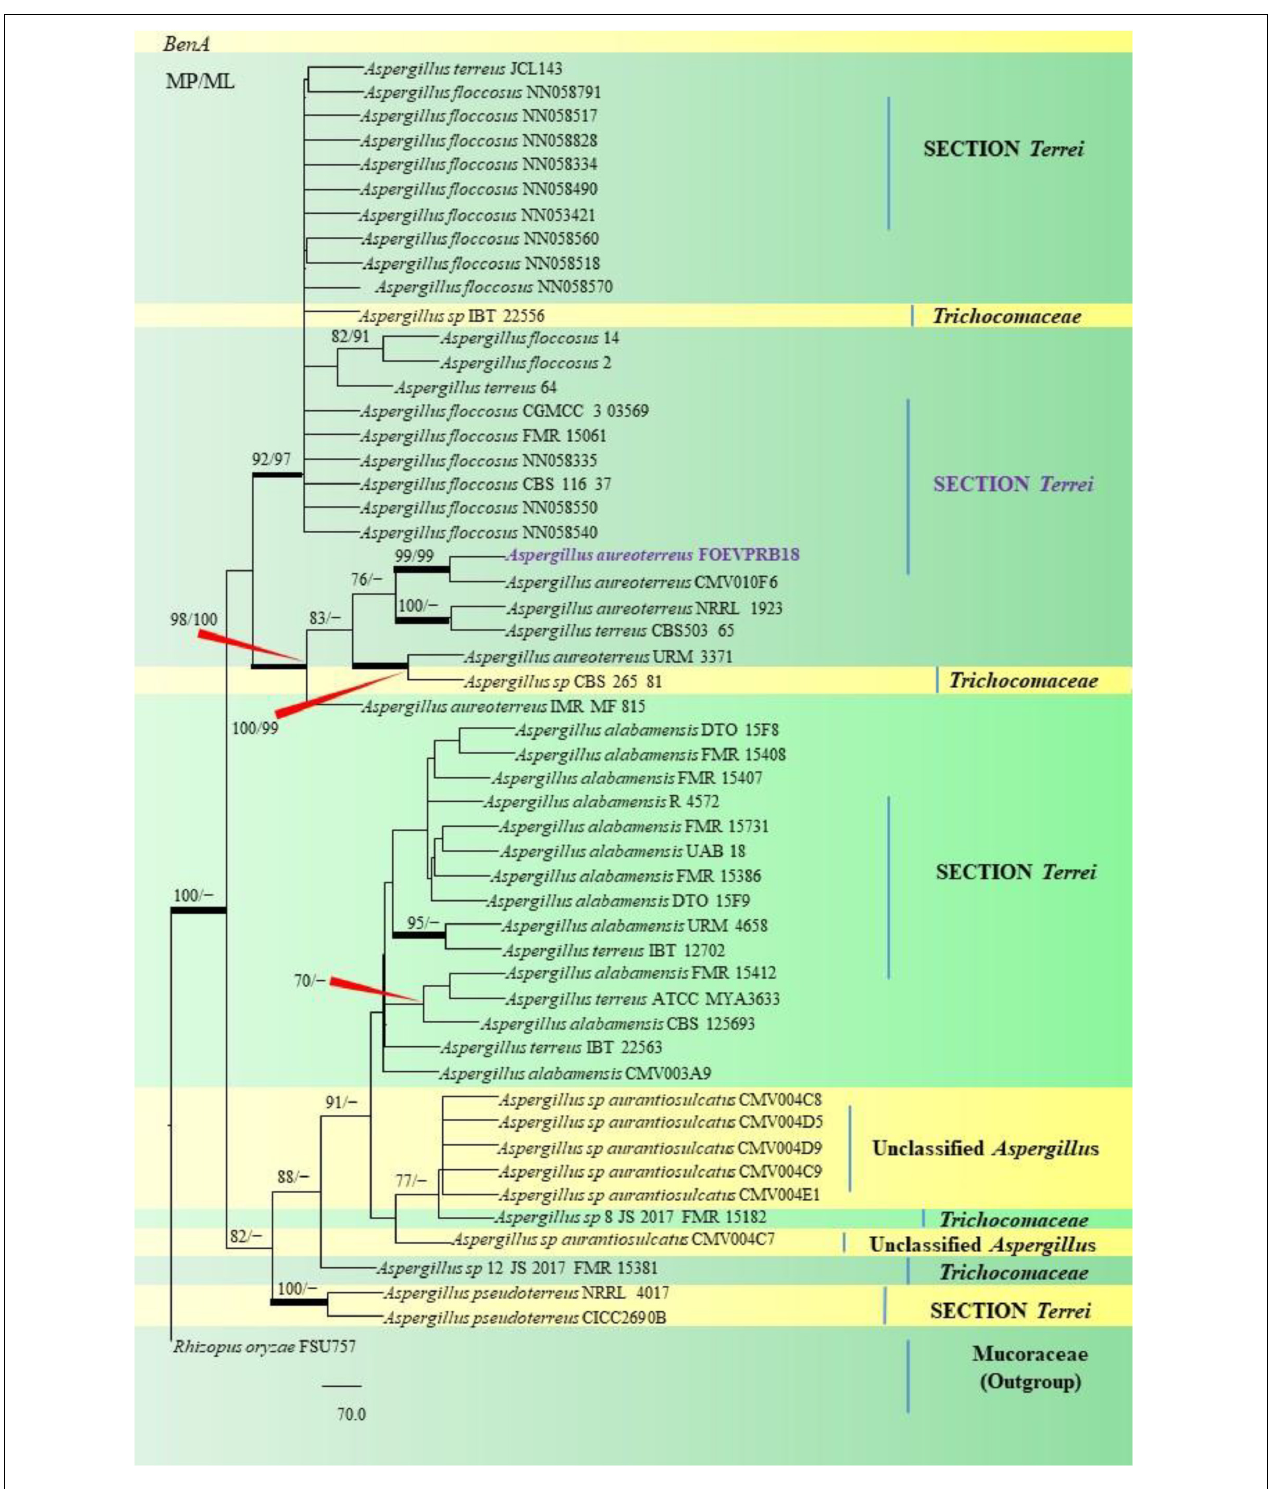
FIGURE 7 | A phylogenetic tree (taxon branching diagram) presents the genetic analysis of the Aspergillus aureoterreus FOEVPRB18 clade belonging to the Section Terrei , exhibiting a maximum parsimony analysis of partial β -tubulin concatenated sequences, acquired. Bootstrap (bs) values ≥ 70% are designated at the nodes for maximum parsimony (MP) and maximum likelihood (ML) methods; branches with values ≥ 95% bs are bold black. A specific isolate code was mentioned as a suffix to the species name. Hyphen (-) represents the range of support values for parsimony and RAxML analyses of below 70%. Our isolate, which is marked in purple, was rooted using Rhizopus oryzae